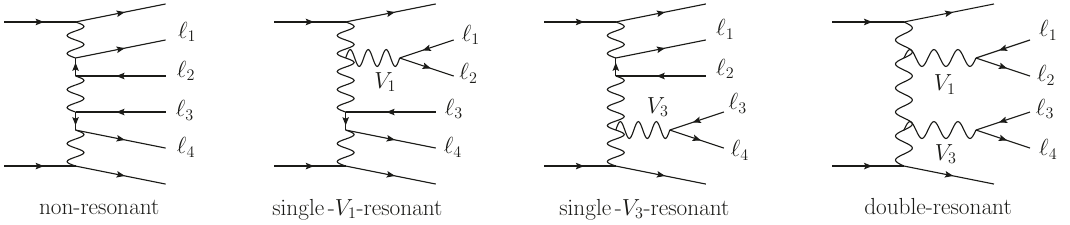
Figure 1 . Sample tree level diagrams for VBS at the LHC. Scattering diagrams (like the rightmost one) are only a subset of double resonant